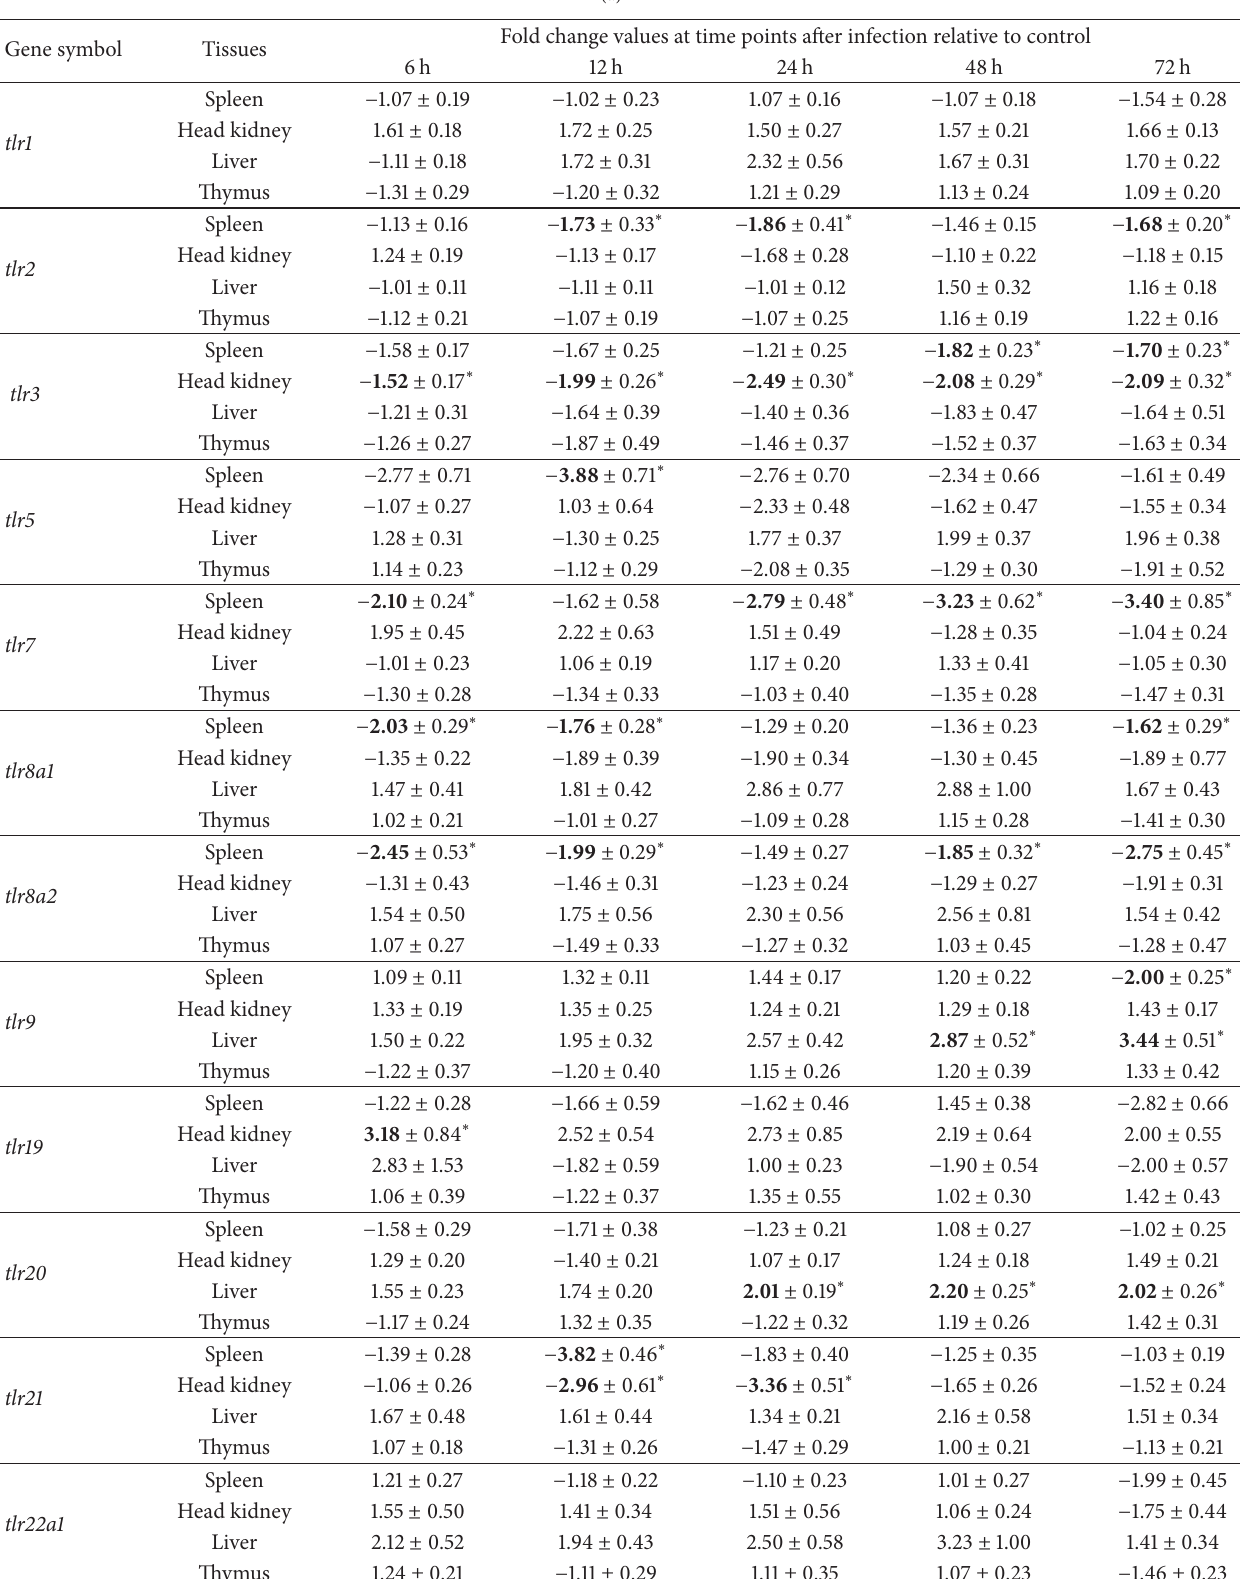
Table 3: (a) Expression profiles of various PRRs in selected tissues of rainbow trout at different time points after infection. (b) Expression profiles of various downstream factors in selected tissues of rainbow trout at different time points after infection. (a) Gene